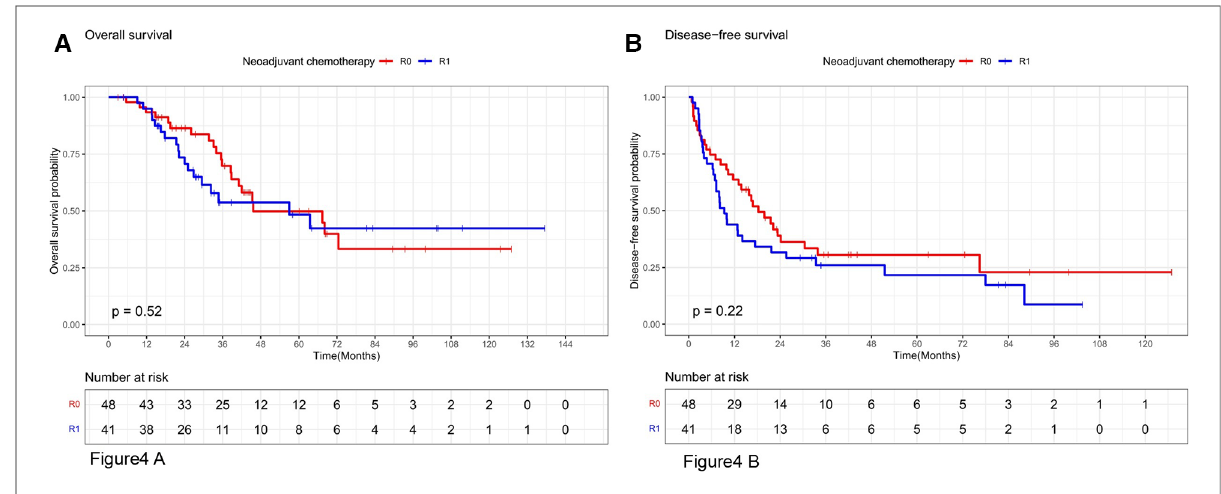
FIGURE 4 Os and DFS survival curves for R0 and R1 in patients receiving neoadjuvant